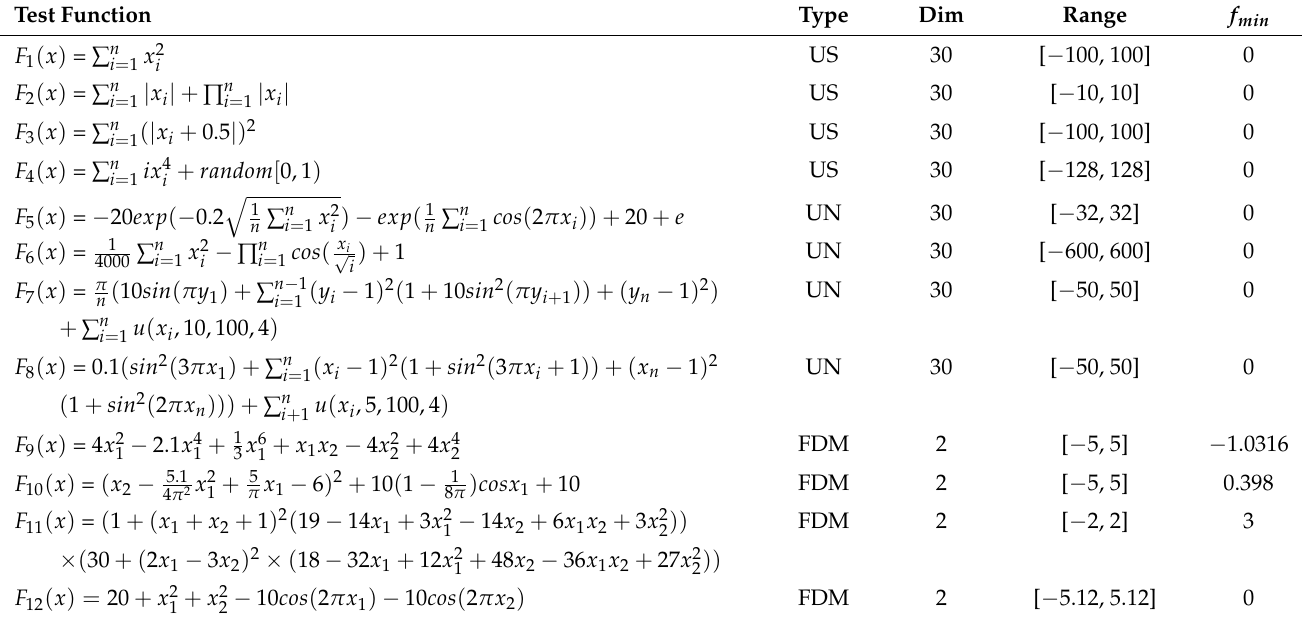
Table 1. Benchmark